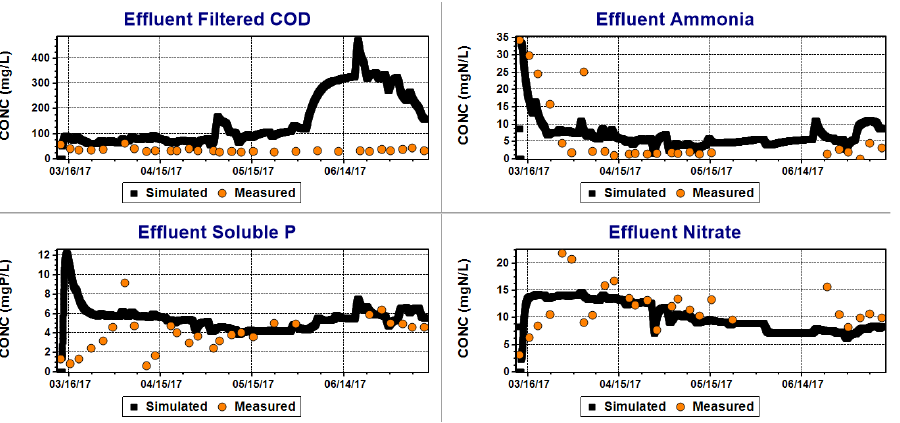
Figure 4. Period IV — simulated effluent concentration of COD, ammonia, soluble P, and nitrate vs. Figure 4. Period IV—simulated effluent concentration of COD, ammonia, soluble P, and nitrate vs.